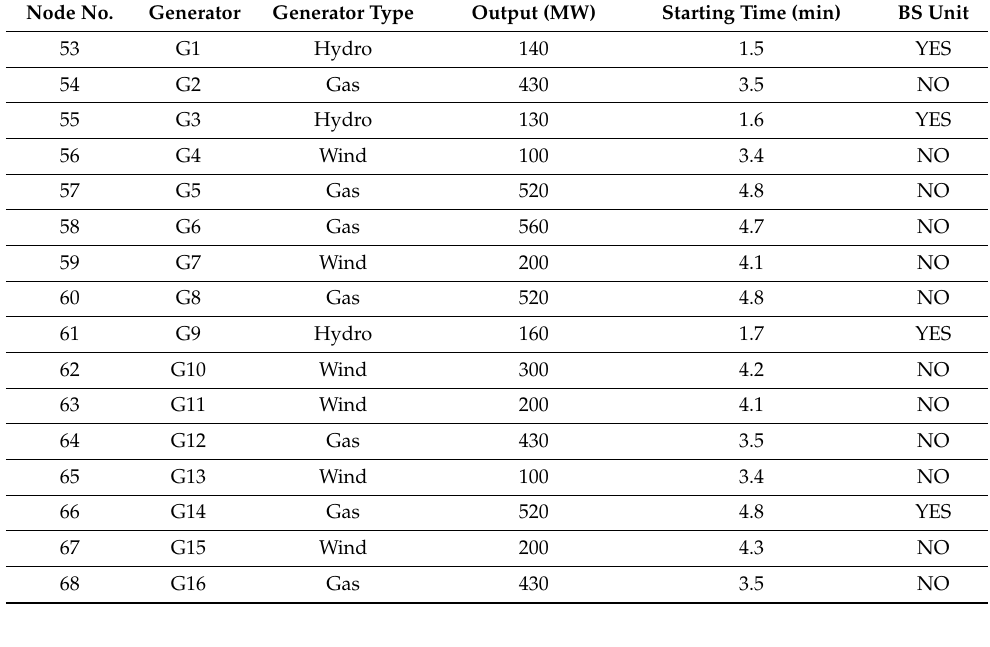
Table 9. Data generators for the IEEE-68 bus system and its classification.